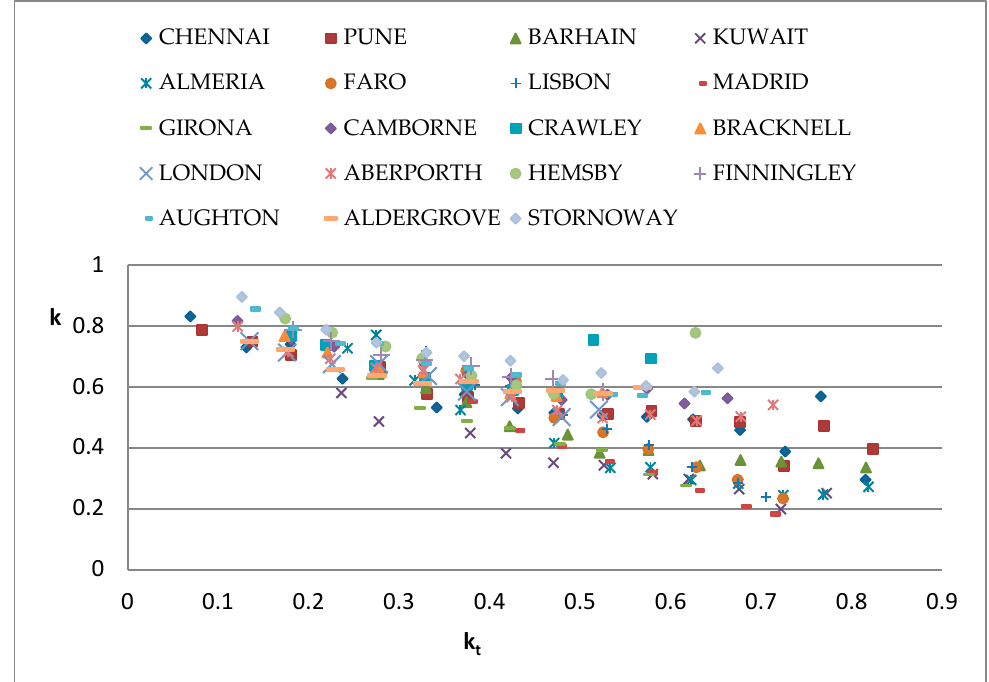
Figure 8. Regression of averaged values of k t vs. k for the 19 locations.